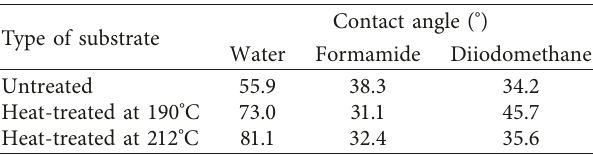
Figure 1: Increase of dark coloration of beech wood with increasing of treatment temperature. Untreated samples (a) and heat-treated samples at 190 ° C (b) and 212 ° C Table 1: Contact angle of water, formamide, and diiodomethane on untreated and heat-treated beech wood at 190 ° C and 212 ° C [25].